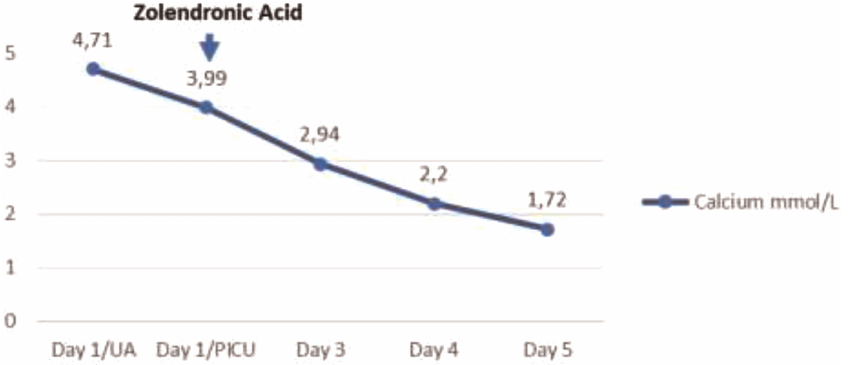
TABLE 2 Calcium (total mmol/L) behavior after zoledronic acid